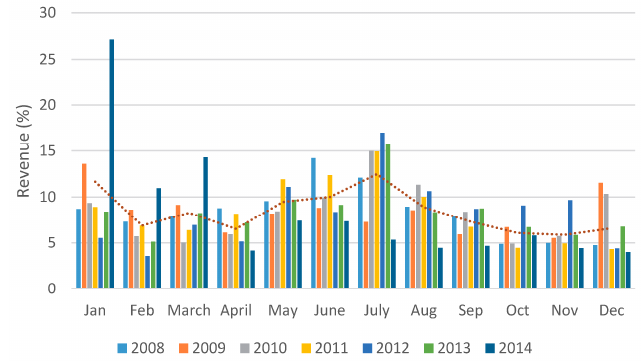
Figure 16. Monthly-based average percentage of annual potential arbitrage revenue for PJM in RTM normalized per year, considering 7395 locations. The dotted line connects the multi-year monthly average.